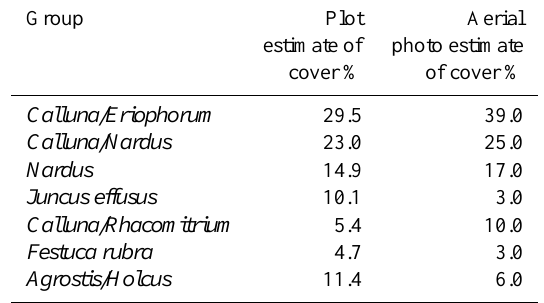
Table 3. Comparison of broad vegetation group covers on the Walls Peninsula: plot estimates versus aerial photography